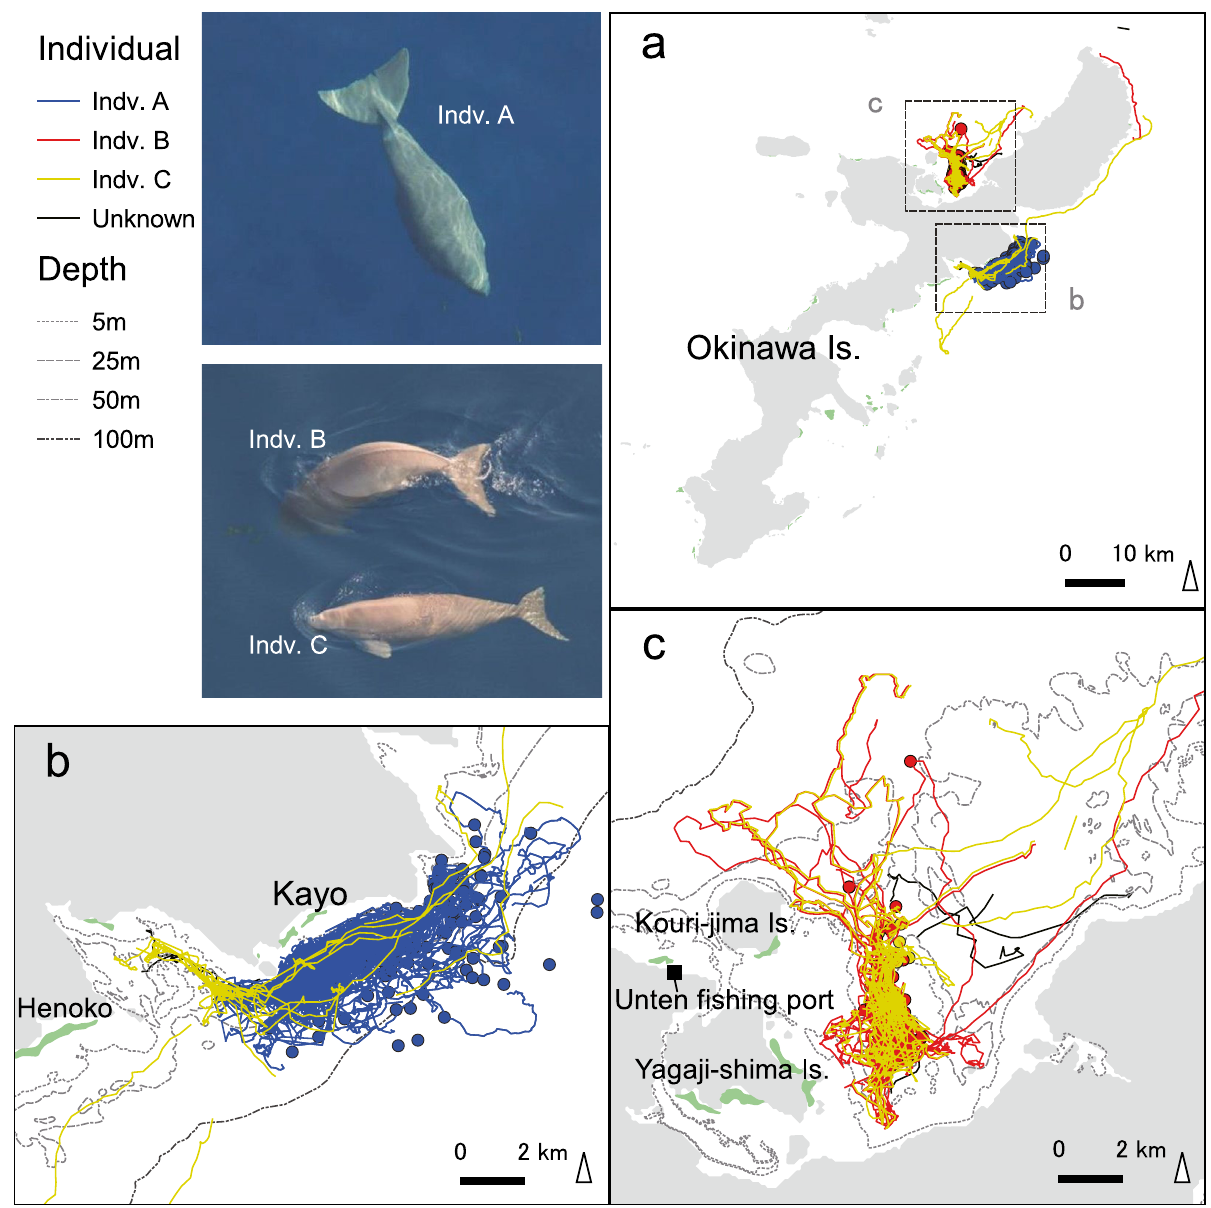
Figure 3. Tracks of the three dugongs (A, B, and C) identified since 2007 (ref. 30,31 ). ( a ) Tracks around Okinawa Island. ( b ) Tracks on the coast of Kayo. ( c ) Tracks on the eastern side of Kouri-jima and Yagaji-shima Islands. Maps were created by QGIS, ver. 3.10.6, https:// www. qgis. org/ ja/ site/ forus ers/ downl oad.